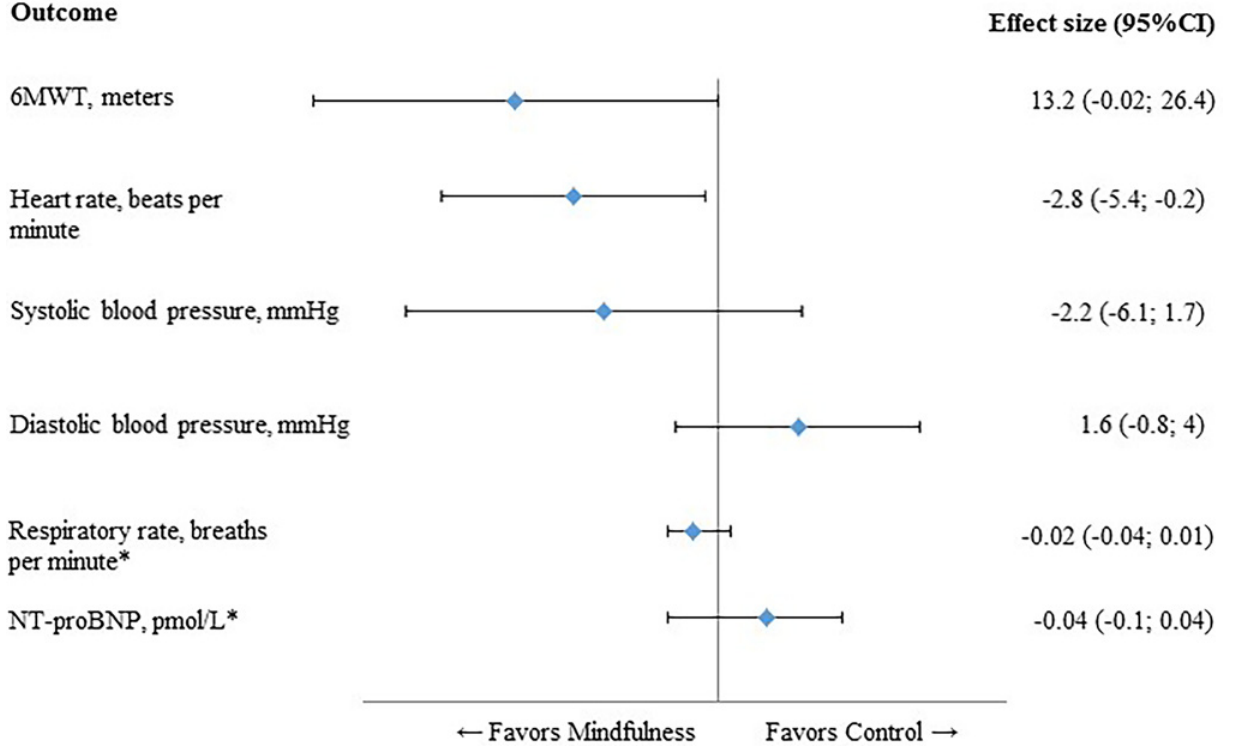
Fig 2. Forest plot of physiological outcomes. All values on the left of the Y-axis indicate a difference in favour of the mindfulness group. 6MWT, six-minute walk test; IC, confidence interval, NT-proBNP, N-terminal pro-brain natriuretic peptide; * Log-transformed